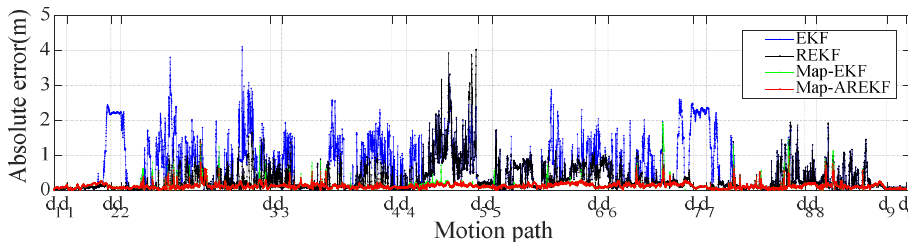
Figure 28. Error of the four positioning algorithms for Experiment 4.